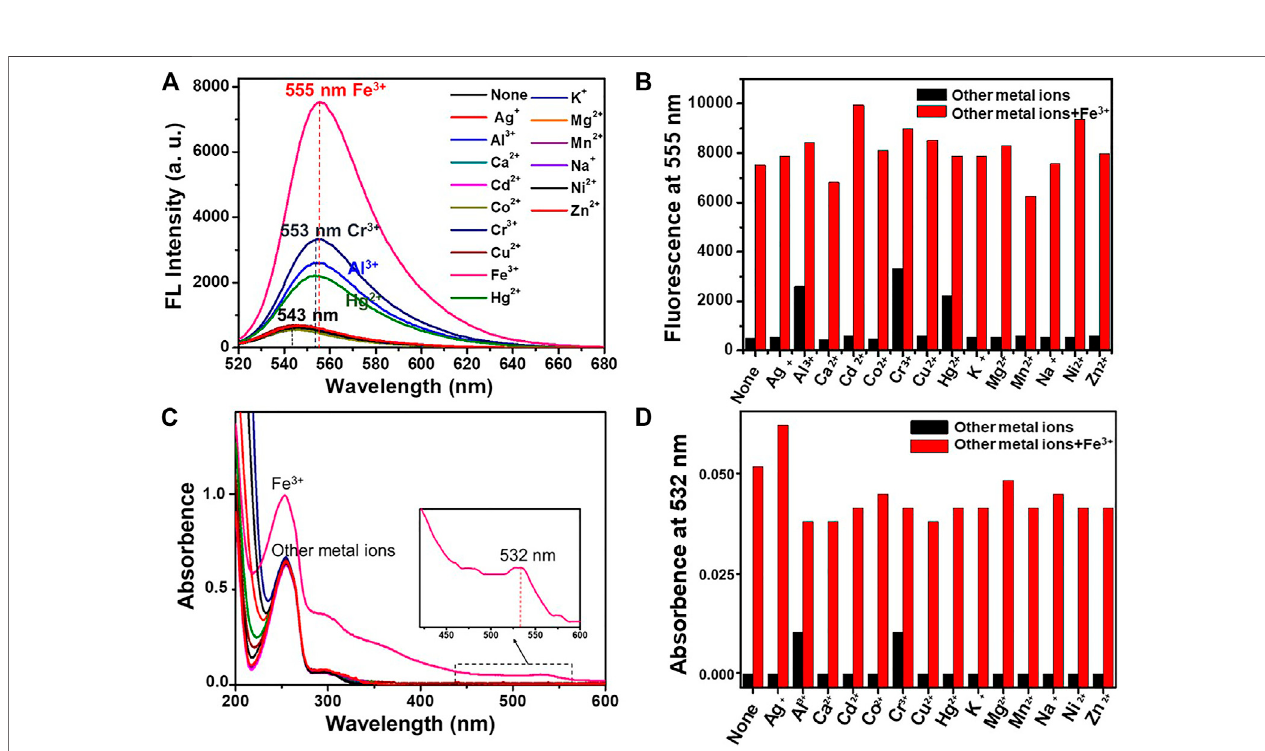
Frontiers in Chemistry |